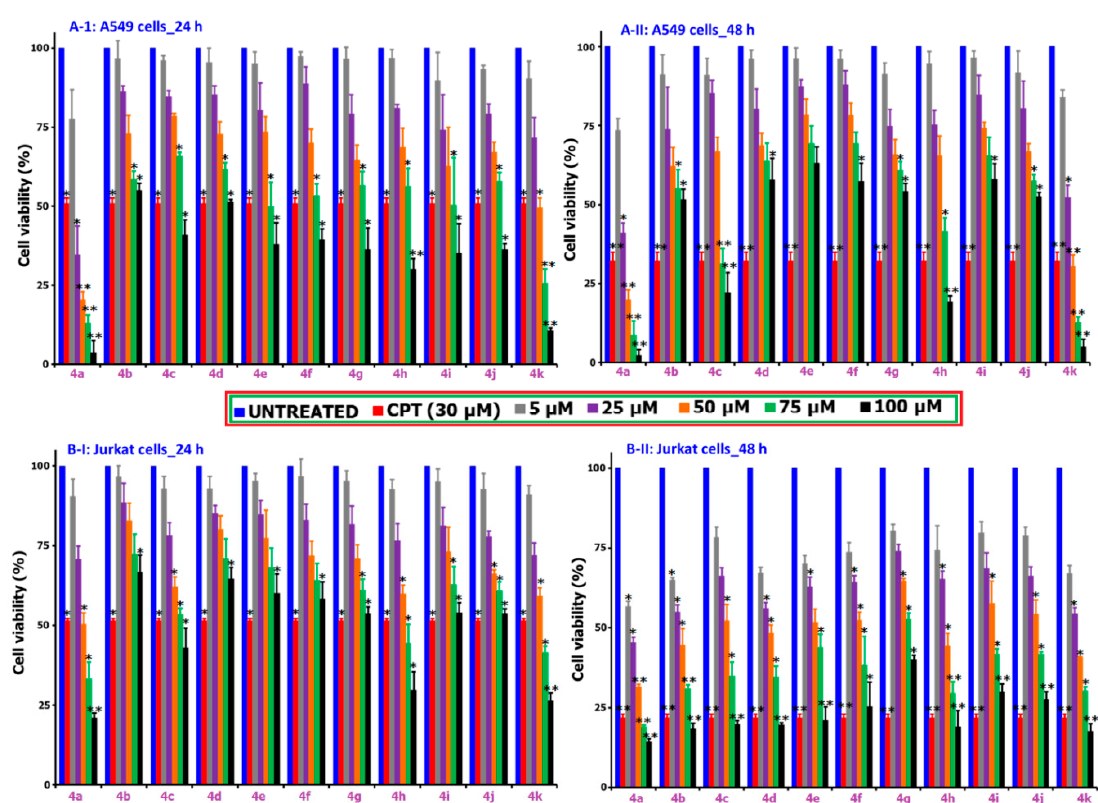
Figure 4. MTT assay comparison of A549 and Jurkat cells at the two different intervals of 24 h and 48 h for the samples 4(a – k) over a concentration range of 5–100 μ M.